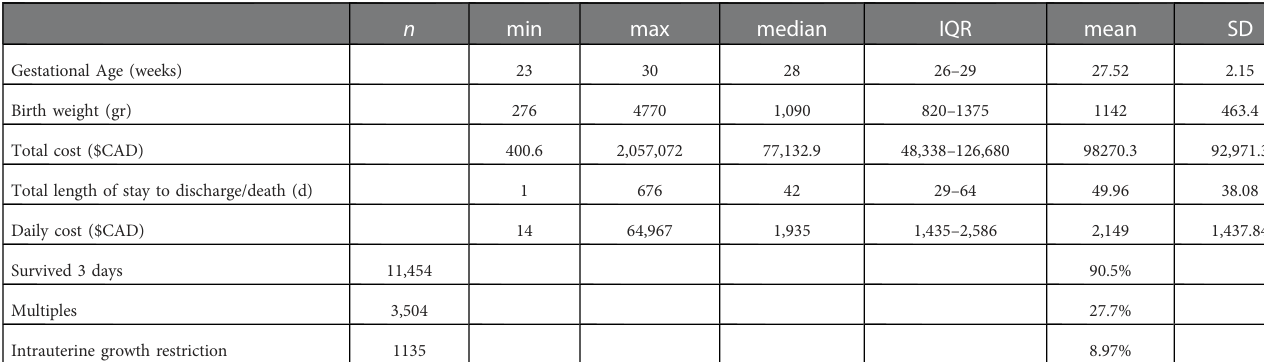
TABLE 1 Cost data review.